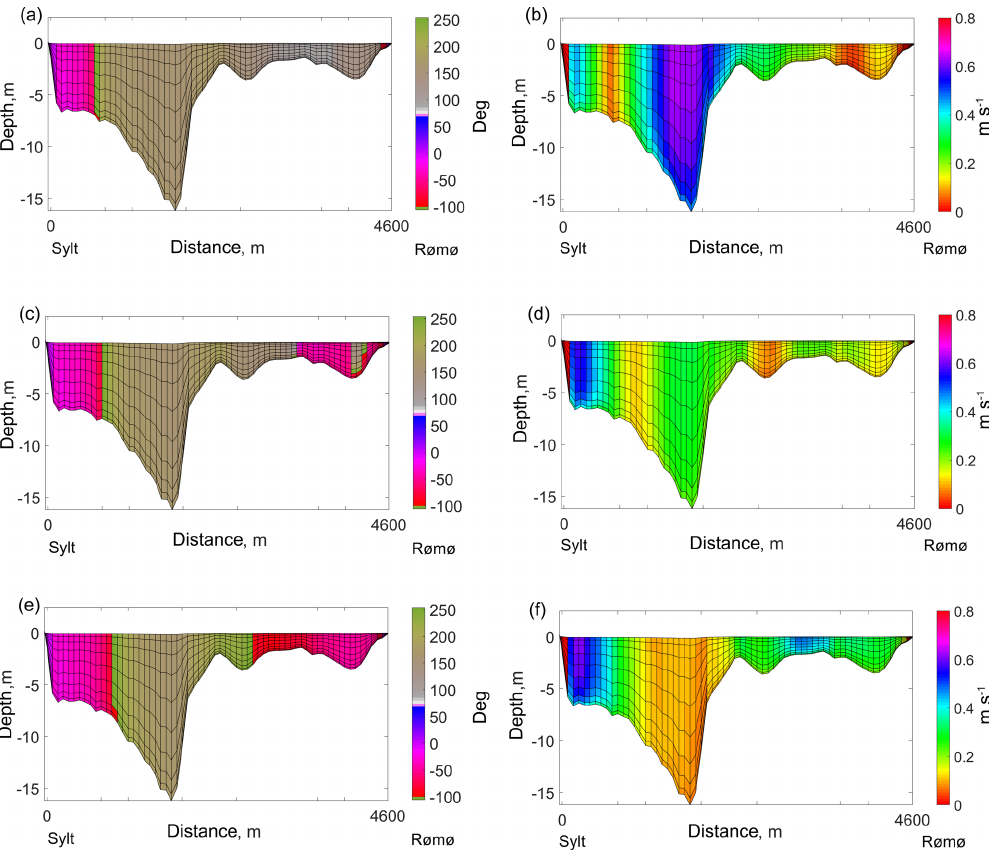
Figure 10. Snapshots of direction relative to the y axes (counted positively anticlockwise) ( ◦ ) and magnitude (ms − 1 ) of velocities within the cross-section which connects Sylt (left shore) and Rømø (right shore); the angle between y axes and the cross-section is − 16 ◦ . In the left panel, the grey-green colour indicates water outflow; blue-red colour indicates water inflow. The snapshots capture the transition phase from ebb to flood with a 20min interval from one picture to another (top to bottom). The top panel is a snapshot of a moment when the external part of the domain is already at first-stage flood and the internal part of the domain is still at last-stage